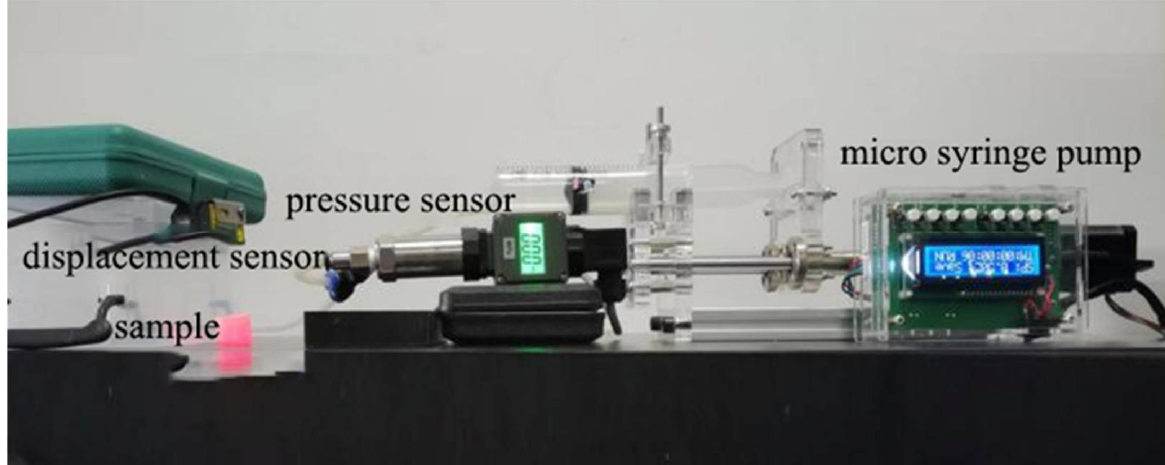
Figure 6. Physical diagram of diaphragm flip quasi-static test rig.